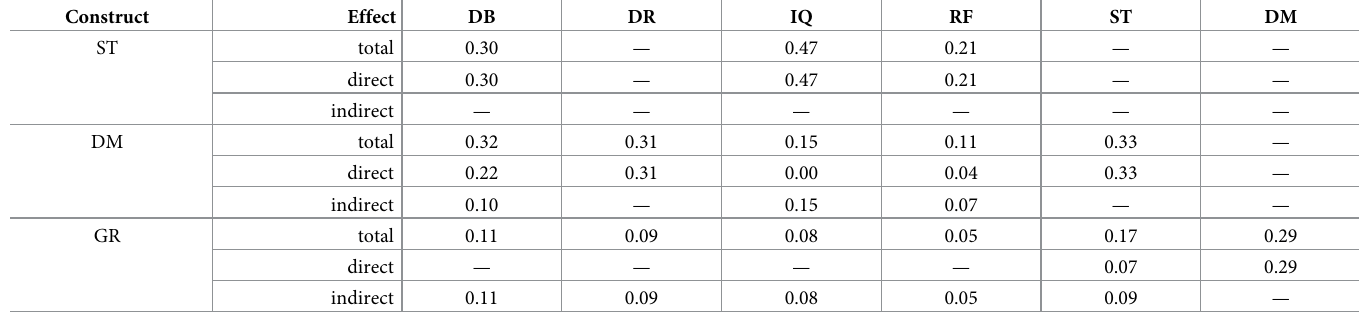
Table 7. Results of the composite path effect.